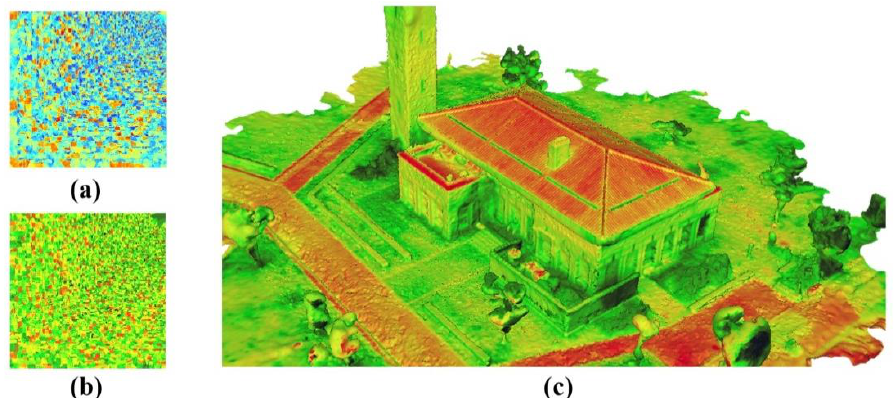
Figure 12. Images of ( a ) the color map in R-G-B, ( b ) the color map in R-B, and ( c ) the 3D model in R-B.